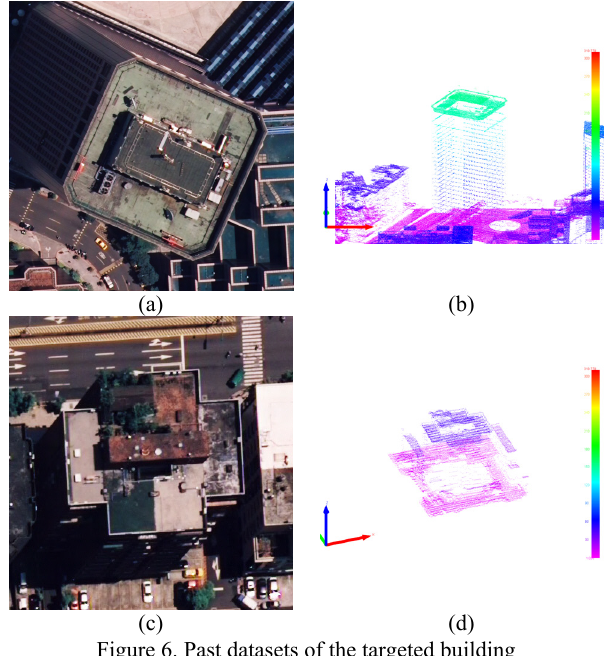
Figure 6. Past datasets of the targeted